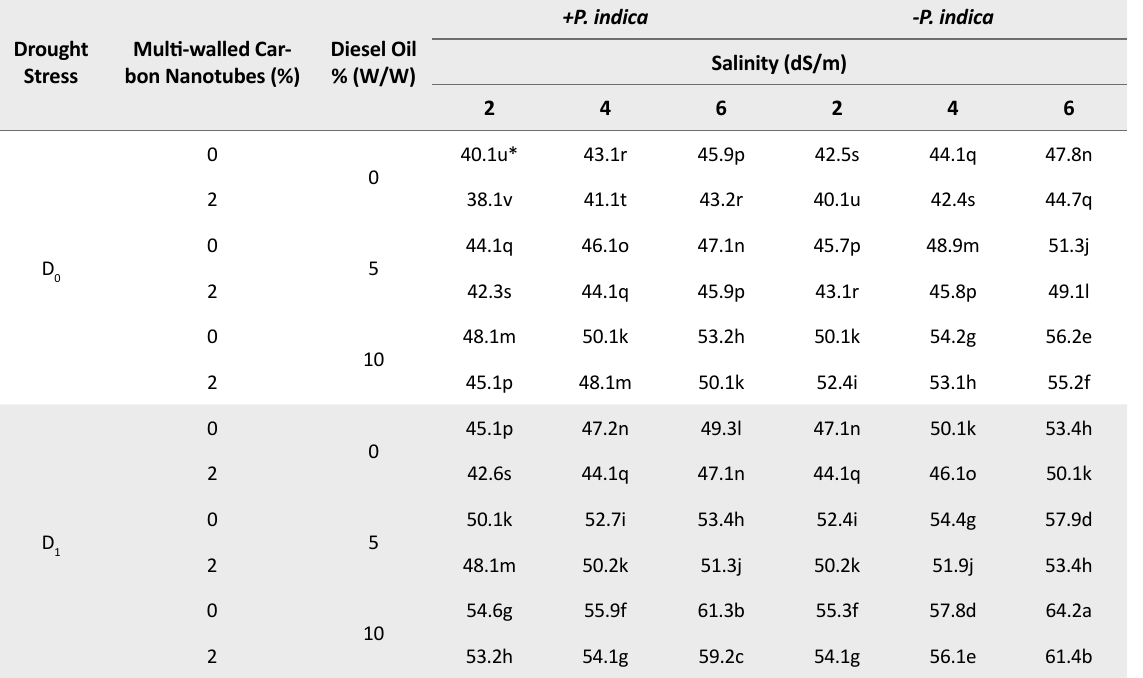
Table 6. The effect of treatments on plant Pb concentration (mg Cd/kg Soil)